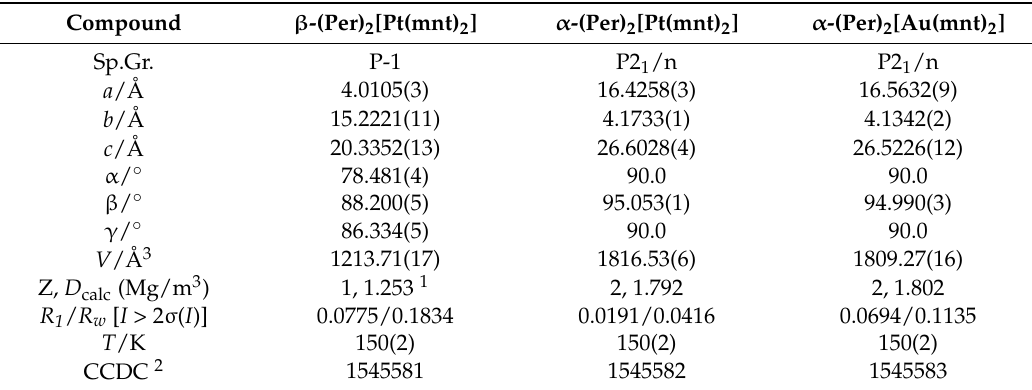
Table 1. Crystal and structural refinement data for (Per) 2 [M(mnt) 2 ]